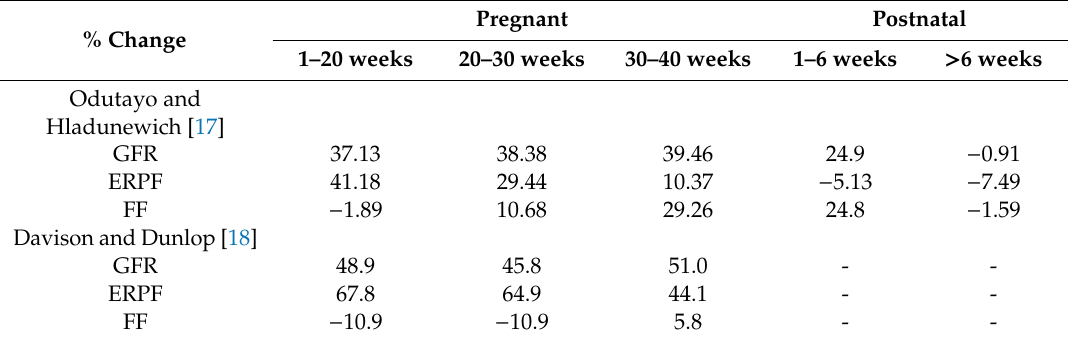
Table 1. Changes in renal haemodynamics variables, glomerular filtration rate (GFR), e ff ective renal plasma flow (ERPF), and filtration fraction (FF) during gestation. The values represent a percentage increase from the baseline, non-pregnant values. Data retrieved from references